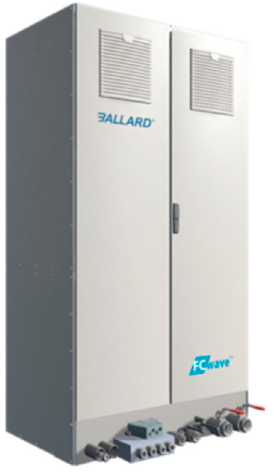
Figure 18. The PEMFC “FCwave” [97].